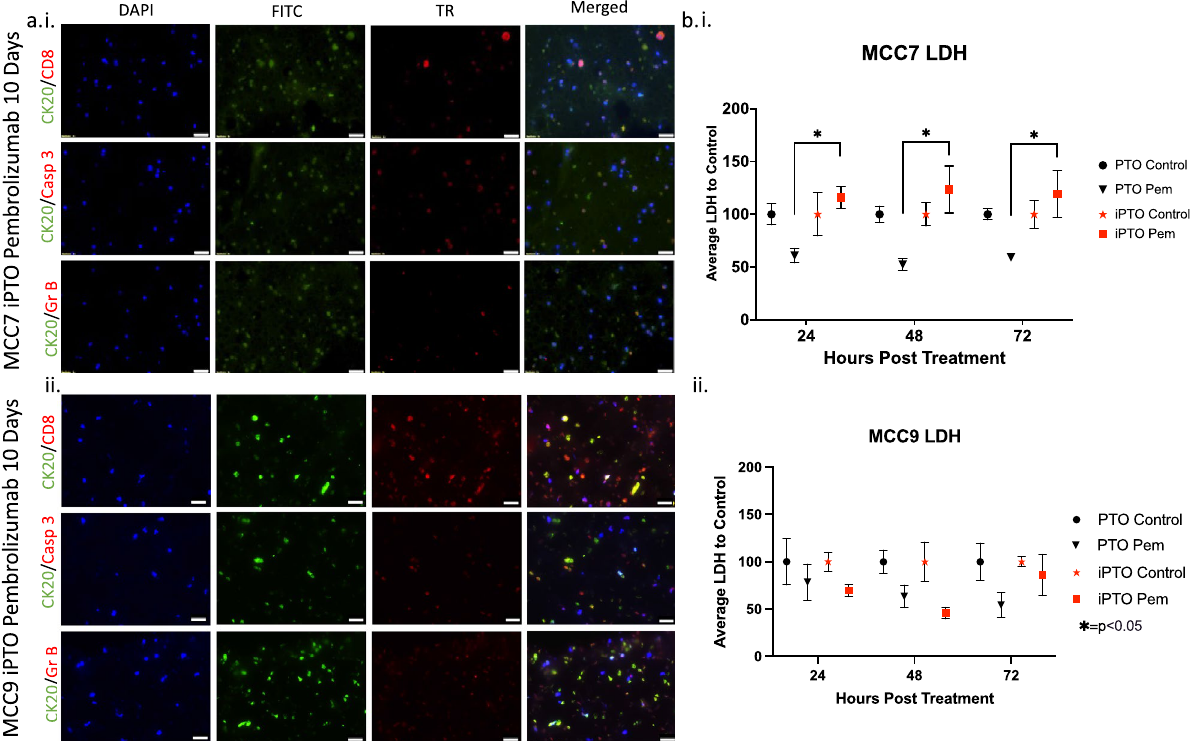
Figure 6. Comparative analysis of tumors temporally separated in the same patient. ( a ) Immunohistochemistry of iPTOs demonstrates robust CD8+ t-cell populations but low granzyme B mediated killing of CK20+ cells. ( b ) LDH cellular stress analysis determines an increase in pembrolizumab MCC7 iPTO set but not in MCC9, suggesting acquisition of resistance between the two tumors in this patient. All images taken at 40X magnification with scale bar 20 μM. *p <